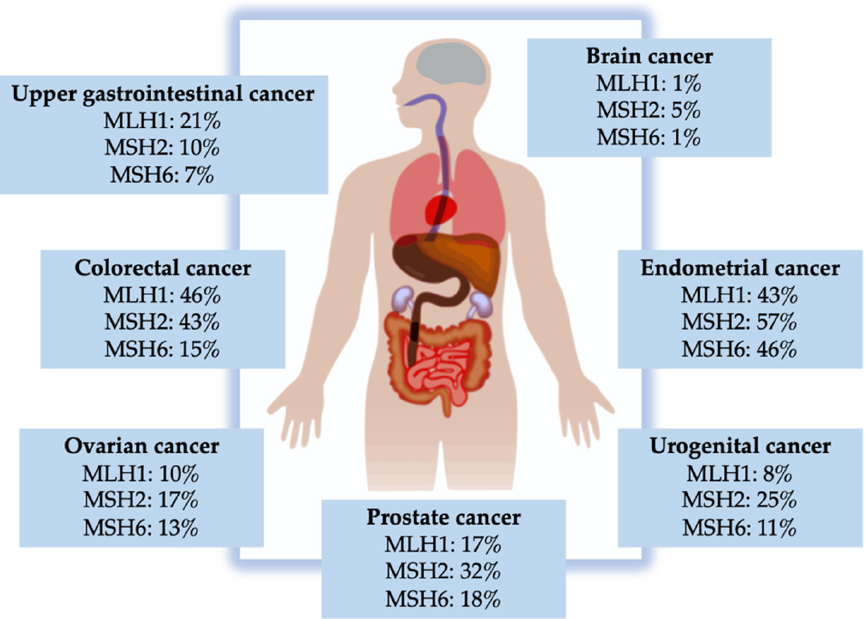
Figure 3. Incidence rate of Lynch syndrome (LS)-associated cancers depending on the involved mismatch repair (MMR) gene mutation up to the age of 75 years [28].